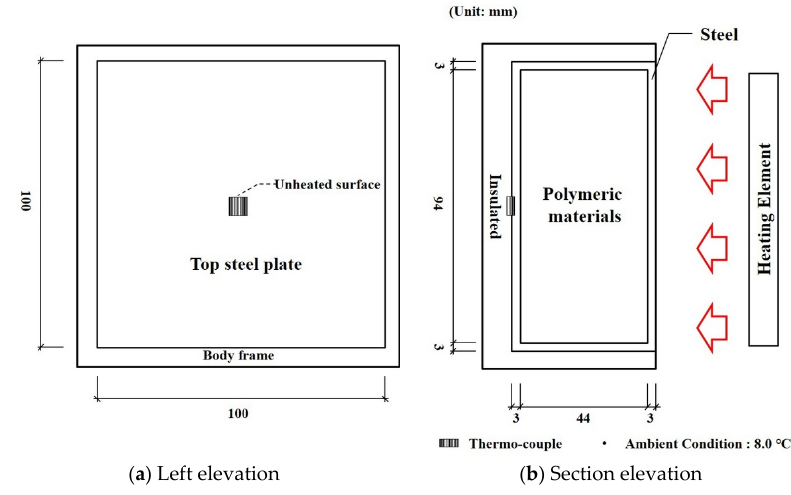
Figure 8. Setup of insulated furnace tests: ( a ) Left elevation ( b ) Section elevation. Materials 2020 , 13 , x FOR PEER REVIEW